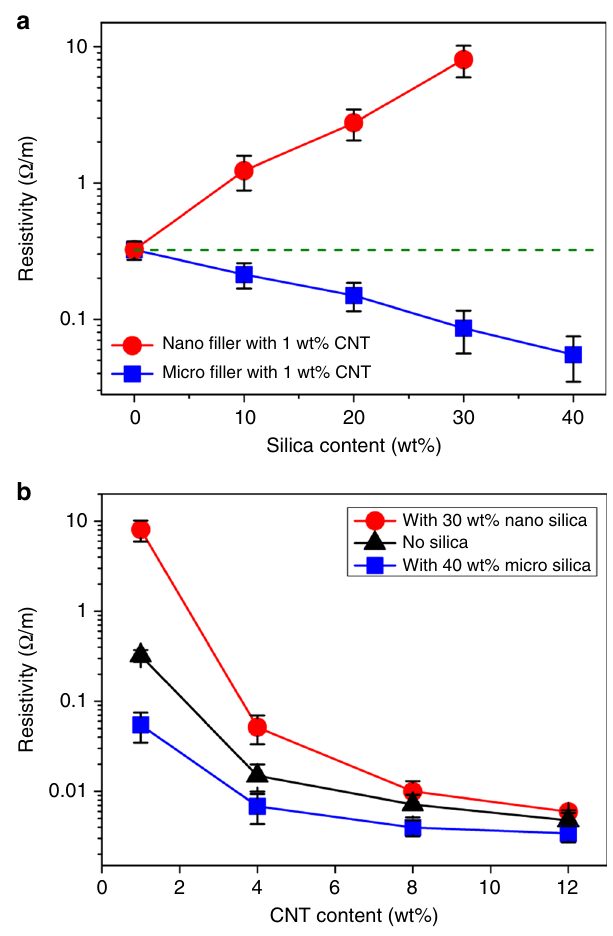
Fig. 4 Variation of resistivity measured by experiment. a Resistivity of the CNT/silica composites (square: micro silica, circle: nano silica) as a function of silica wt% for fi xed CNT content (1 wt%). b The variation of resistivity as a function of CNT wt% for fi xed silica content (micro silica: 40 wt%, nano silica: 30 wt%). Error bars represent the variations of the values measured by 5 independent